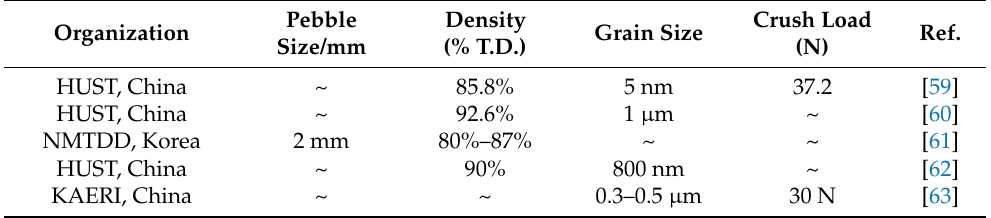
Table 5. Recent developments in the fabrication of Li 2 TiO 3 by solution combustion